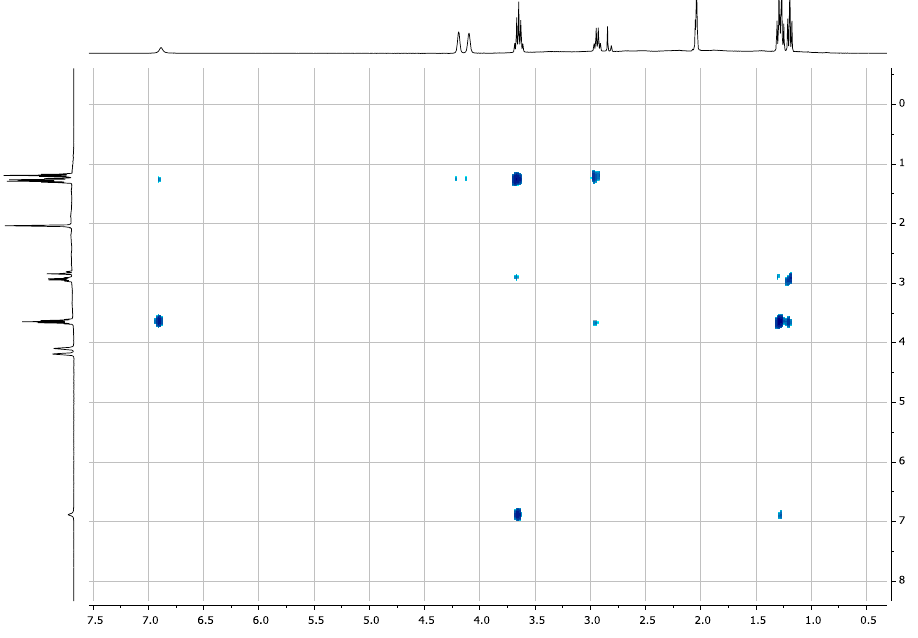
assignment of spectral signals made for the mixtures of E and Z isomers of amidines 1 – 6